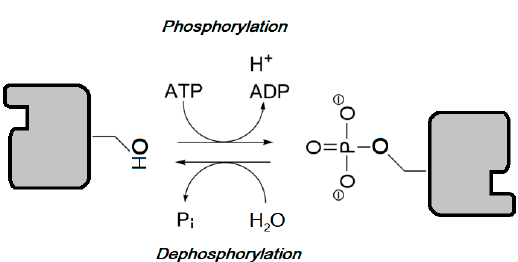
Figure 2. Via phosphorylation, protein kinases chemically transfer γ -phosphate from ATP (or GTP) to a targeted amino acid with a free hydroxyl group from its protein substrate. Protein phosphatases catalyze the opposite reaction, transferring the phosphate from a phosphoprotein to a water molecule.